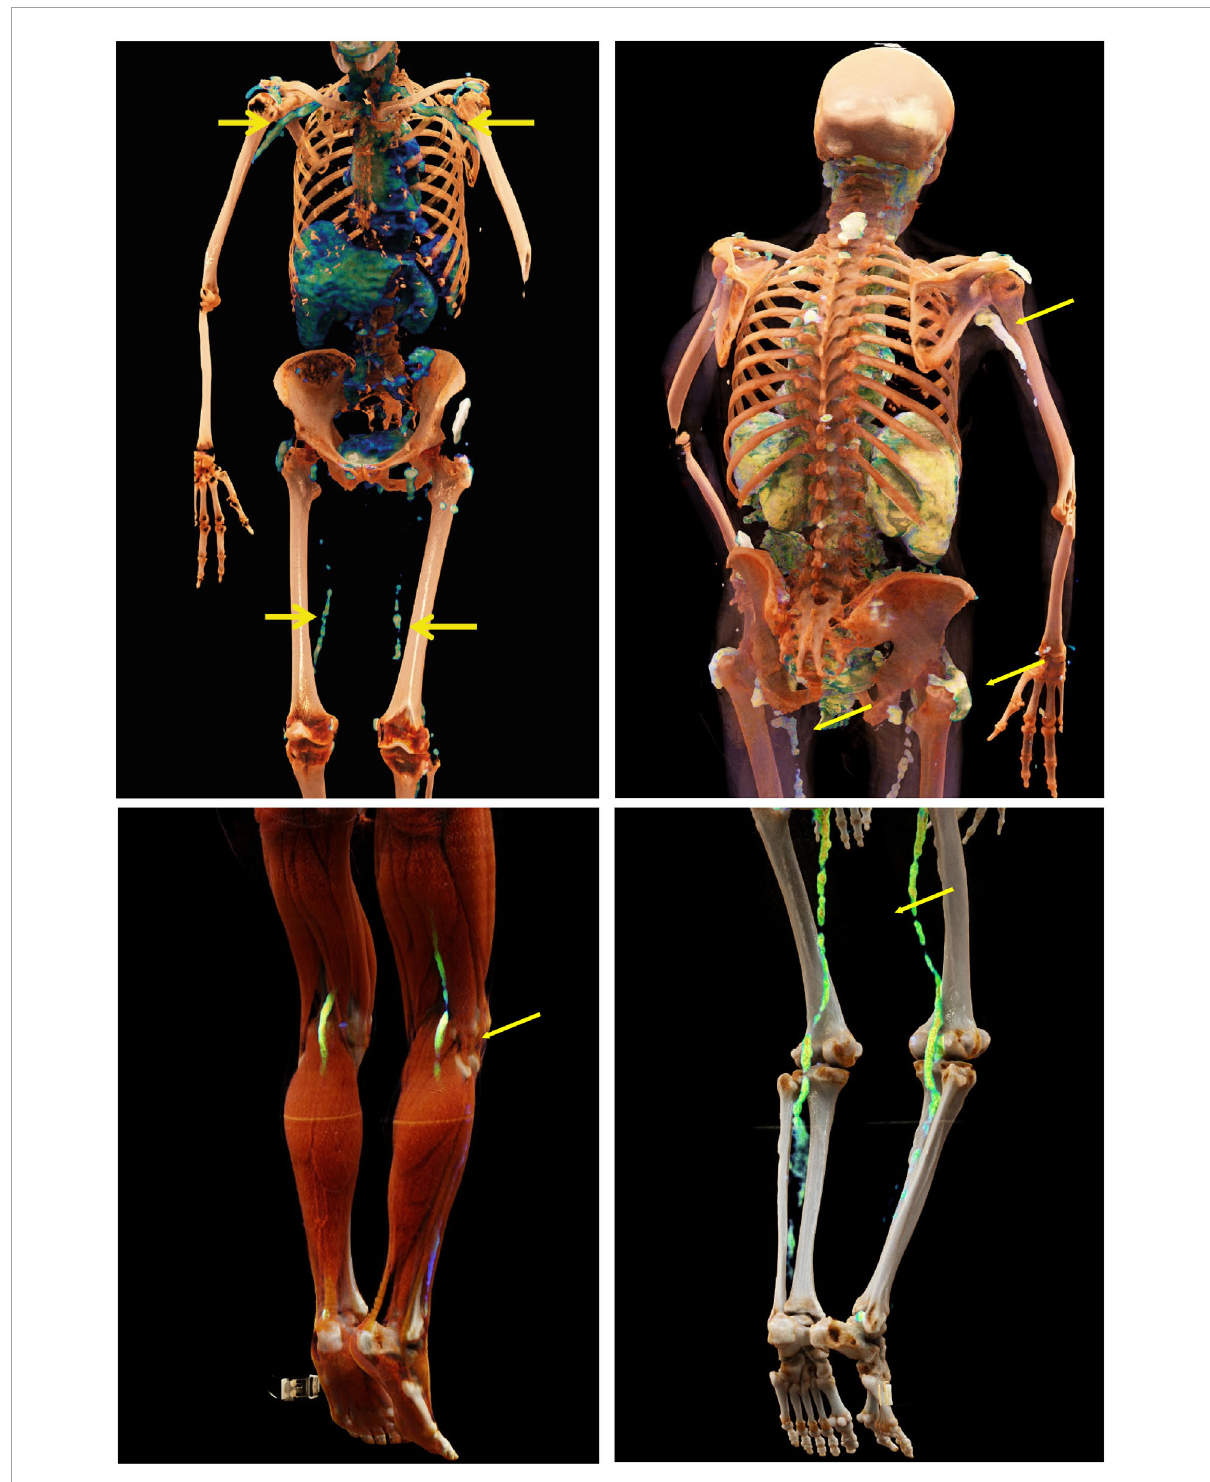
FIGURE4 Cinematic rendering of the large vessels in giant cell arteritis. Cinematic rendering based on fusion images from PET and CT showing inflamed vessels (yellow arrows) in giant cell arteritis. Furthermore, inflammation of subacromial bursae is seen, which is associated with polymyalgia rheumatica. By applying CR on fusion images such as PET-CT scans, patients are easily able to understand the origin of inflammatory processes which are happening on vessel level in their body and thus understand why treatment is